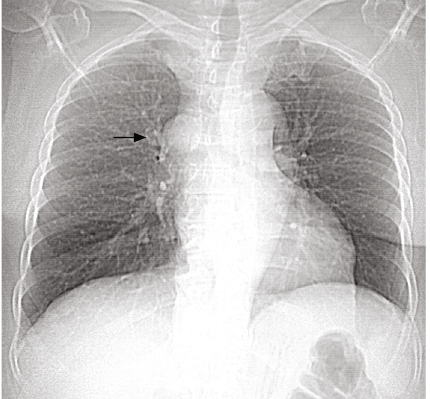
Figure 3: Chest radiograph showing a prominent upper right mediastinum (arrow) as the correlation of the azygos continuation entering the vena cava superior in a cross-sectional